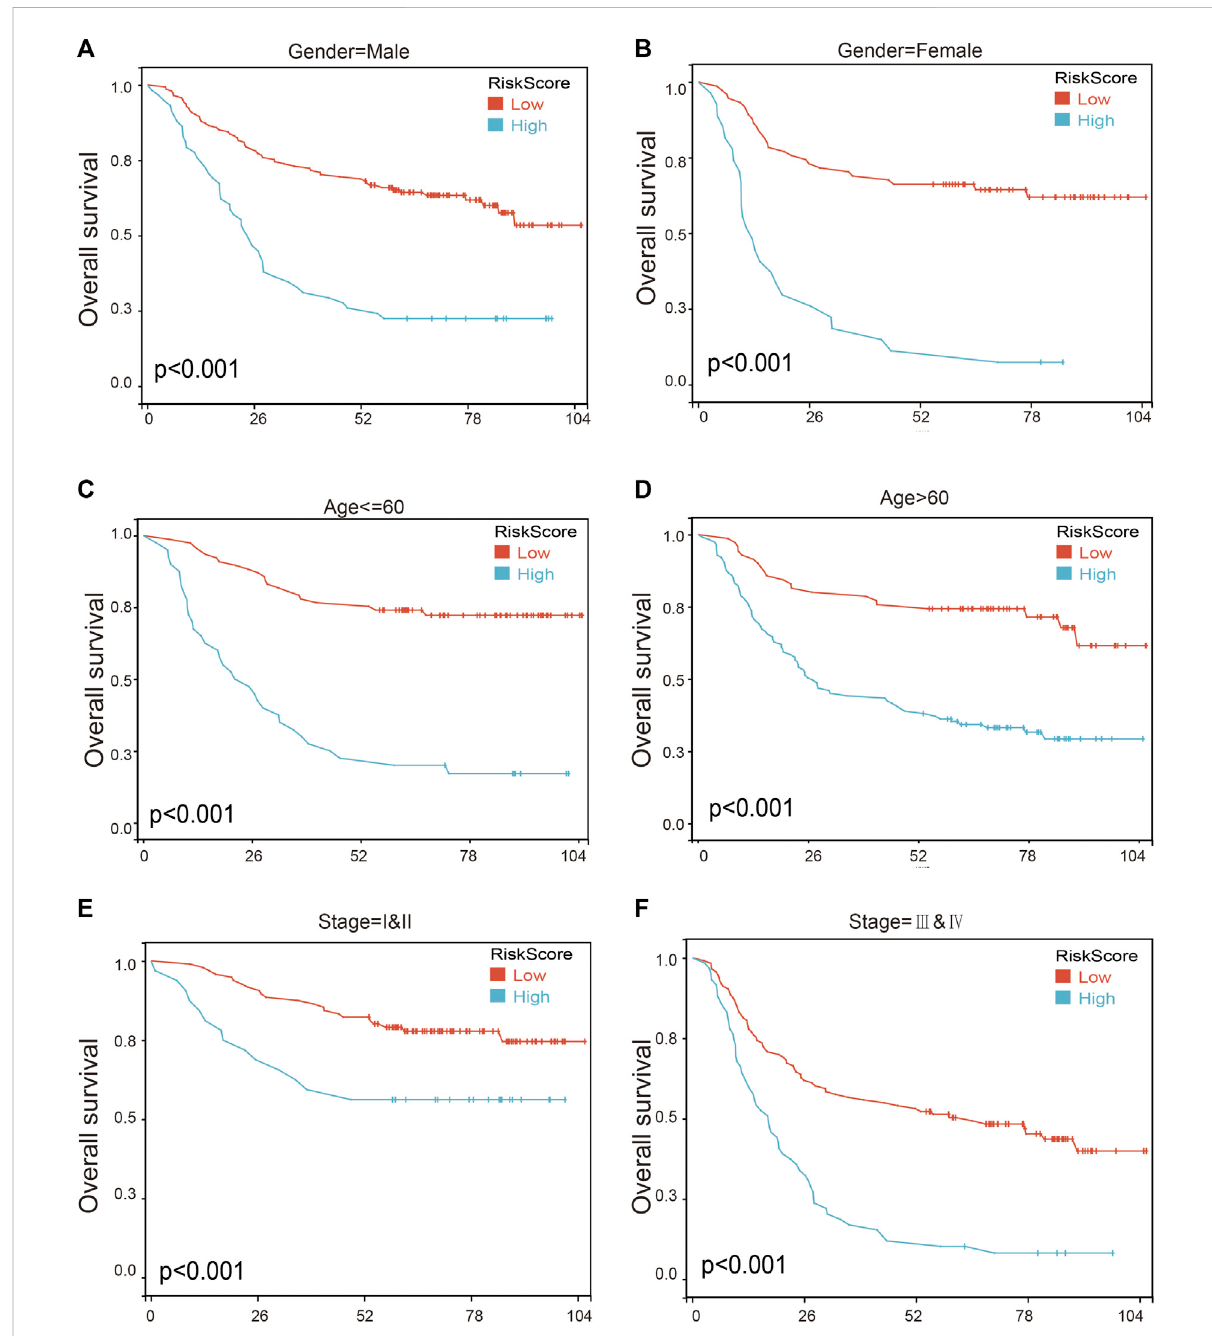
FIGURE 9 The survival analysis in different subgroup of gastric cancer patients according to risk score model. (A,B) Prognostic analysis of gastric cancer patients ingender= female (A) andgender =male (B) subgroups.Prognosticanalysis ofgastric cancerpatients in (C,D) Age ≤ 60 (C) and age > 60 (D) subgroups. (E,F) Prognostic analysis of gastric cancer patients in subgroups of stage = I and II (E) and stage = III and IV (F)